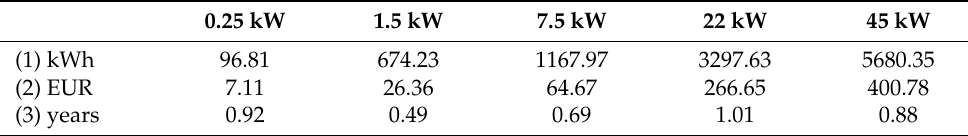
Table 12. Economic evaluation (4500 h/year).